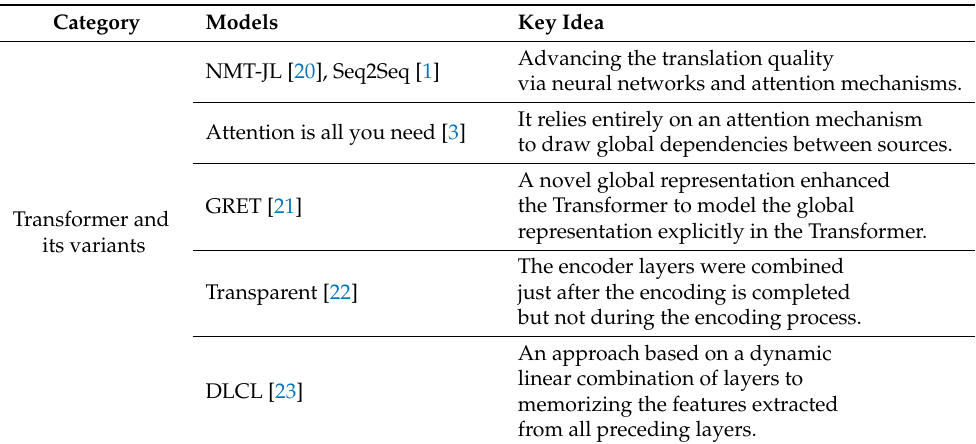
Table 1. Comparison of the related